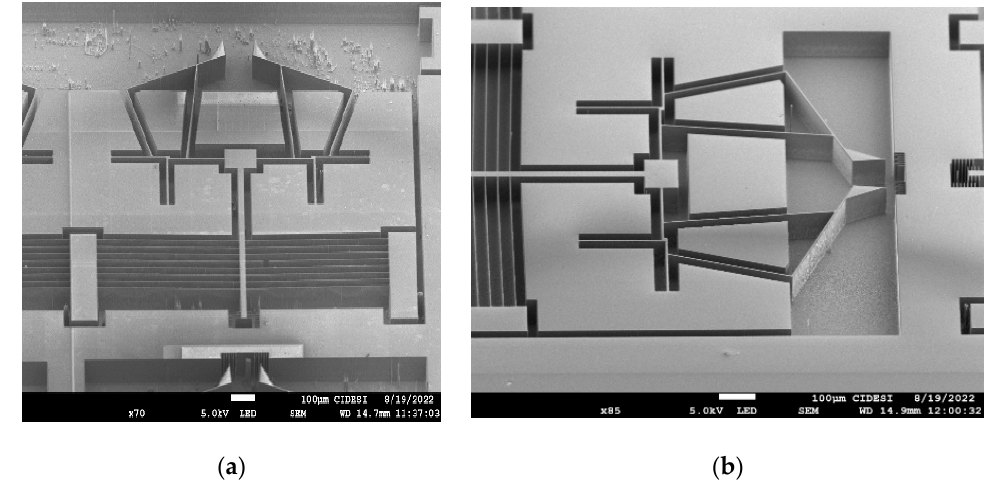
Figure 13. Preliminary results of fabrication in silicon wafers of microgripper Model 2. ( a ) Full geometry, and ( b ) magnification of the microgripper arms and the arrangement of the rotary actu- ators.